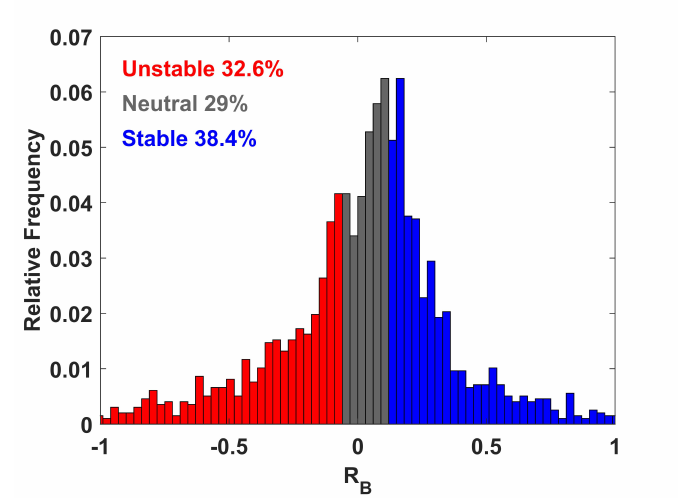
Figure 12. Classification of stability regimes based on distribution of R B .